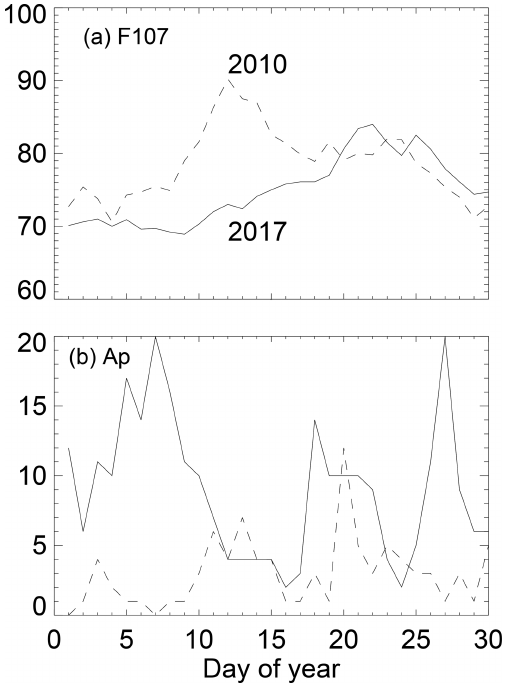
Figure 1. (a) Daily variation of the solar F107 index for January 2017 (solid) and 2010 (dashed). (b) Daily Ap for the same period.